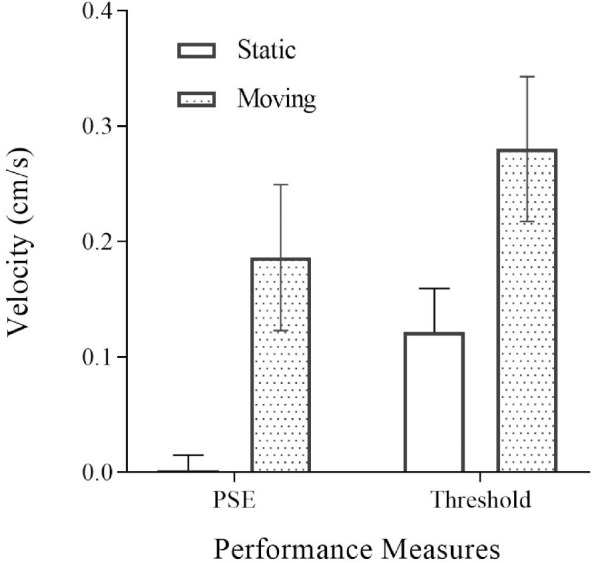
Mean group PSE and direction discrimination thresholds plotted for each condition; static (no fill) and moving (spotted). Error bars are 95% confidence intervals.